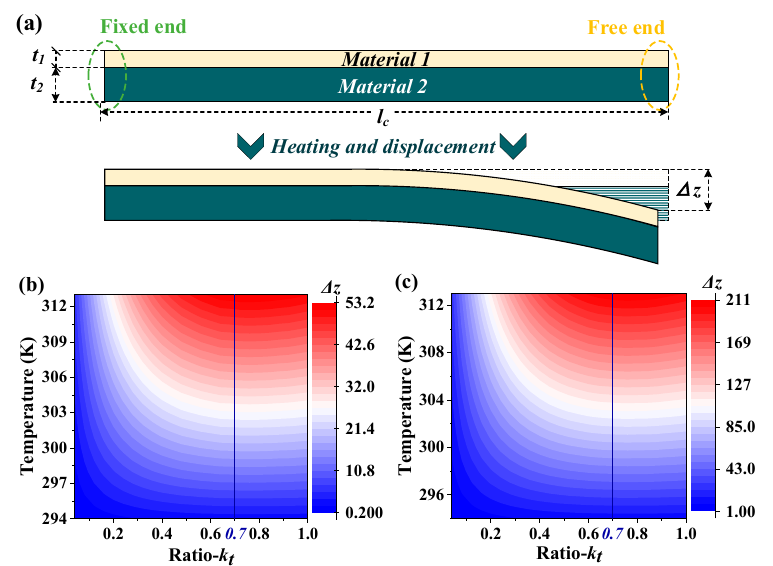
Figure 2. ( a ) Side view of bi-material micro-cantilevers; the length is l c , and t 1 and t 2 are the thicknesses of two materials, respectively; Δ z is the free end displacement. ( b , c ) The simulated thermomechanical responsivity of bi-material micro-cantilevers with different thickness ratios; the length of micro-cantilevers in ( b,c ) are 100 μ m and 200 μ m, respectively.